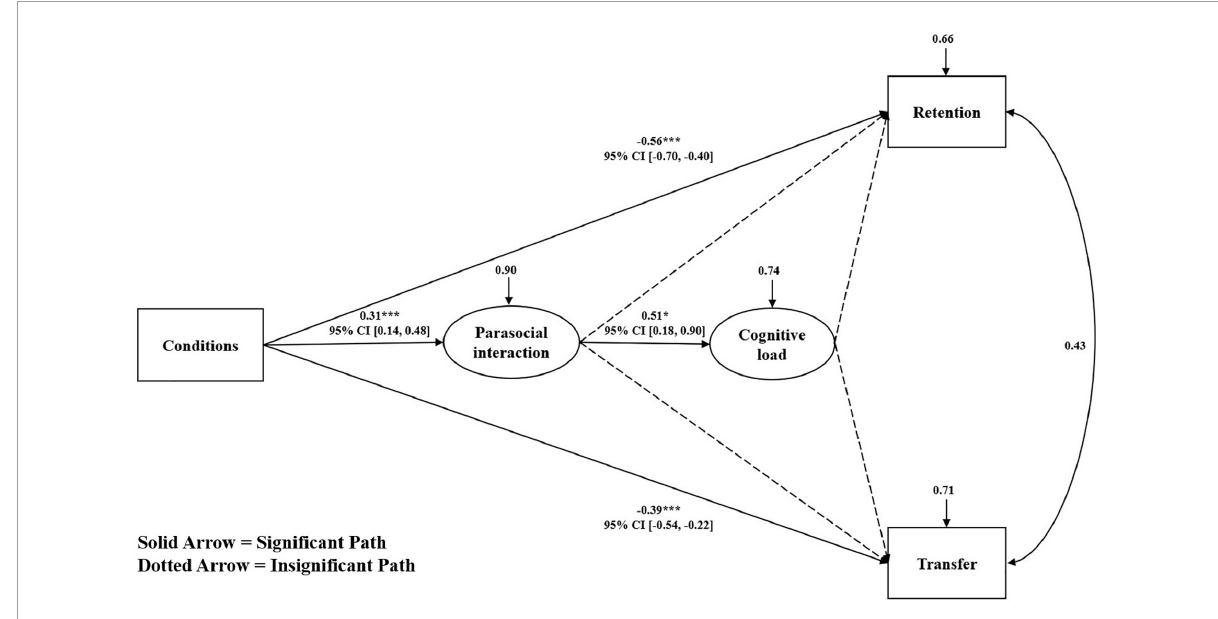
FIGURE7 Mediation analysis with path coefficients. CI, confidence interval. * p < 0.05, *** p <